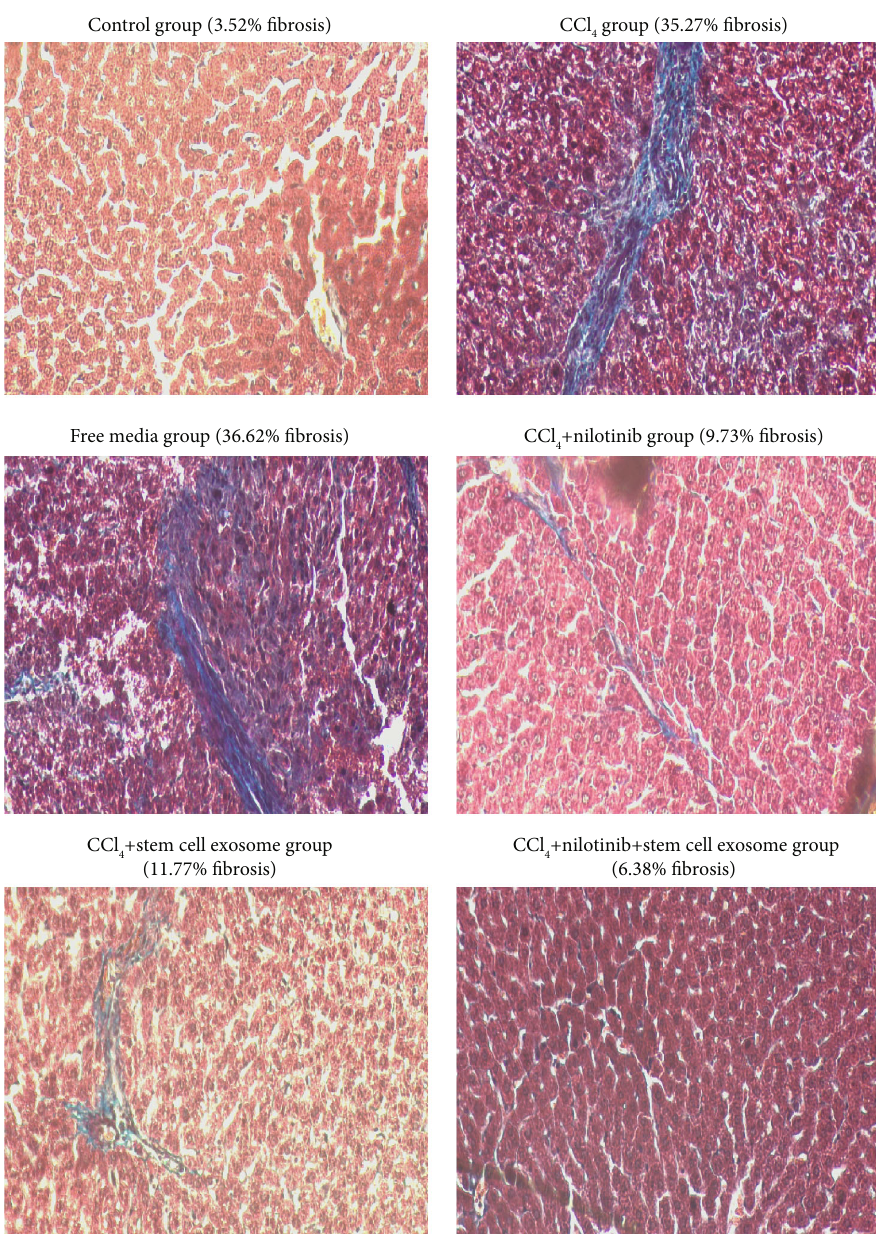
Figure 4: Histopathological examination among the studied